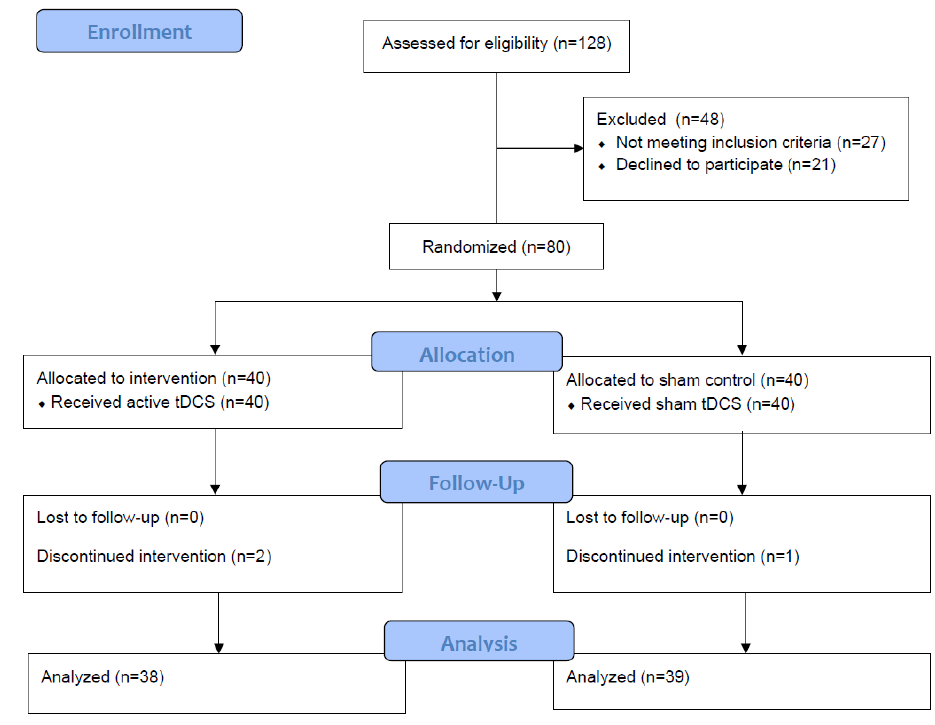
Figure 2. Intervention flowchart. Table 1. Demographic and clinical characteristics at baseline and comparison between groups.